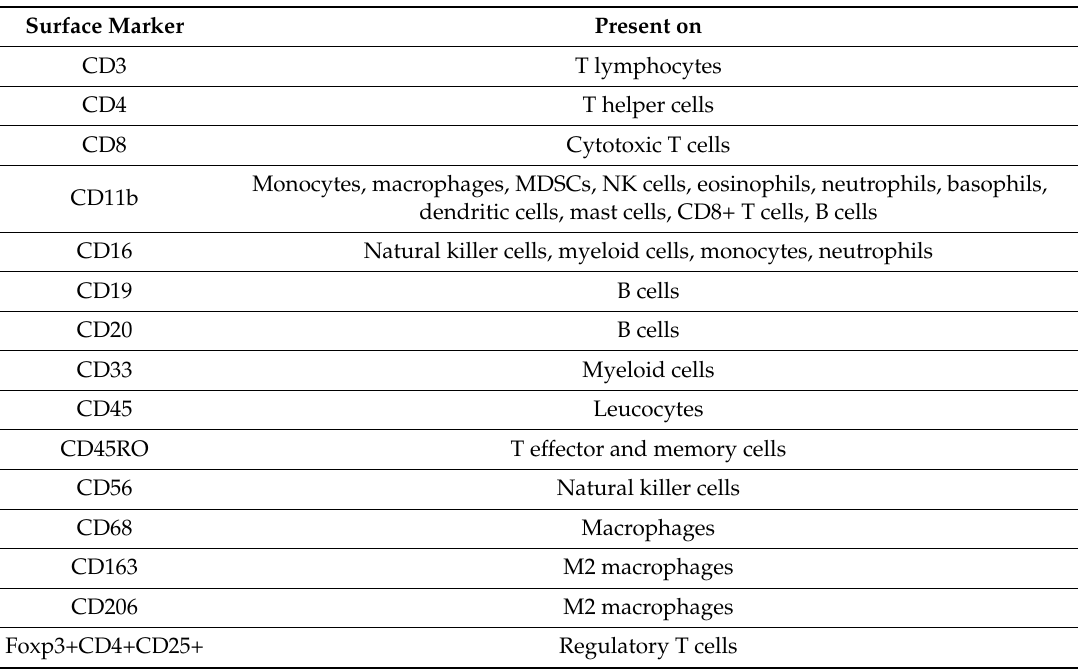
Table 1. Cell surface markers and correlating immune cell type.